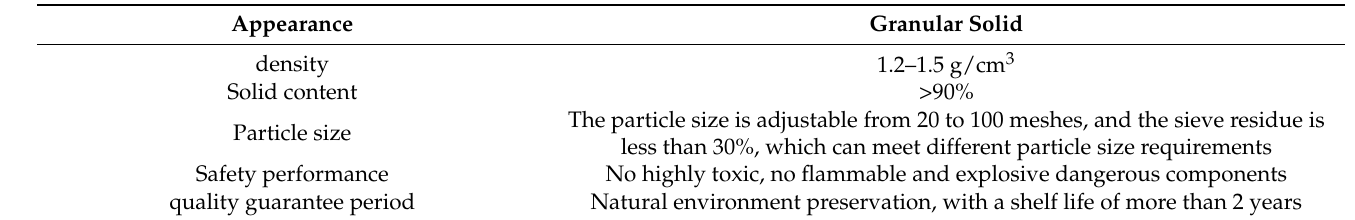
Table 1. Physical and chemical properties of rubber particles.